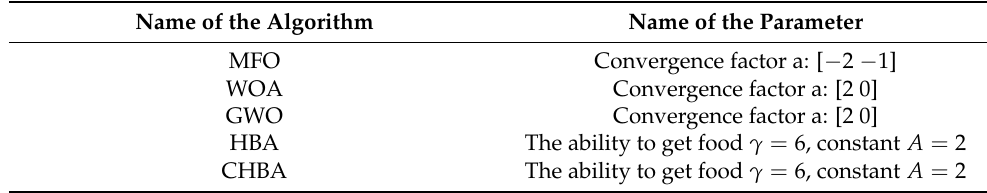
Table 1. Algorithm parameter settings.